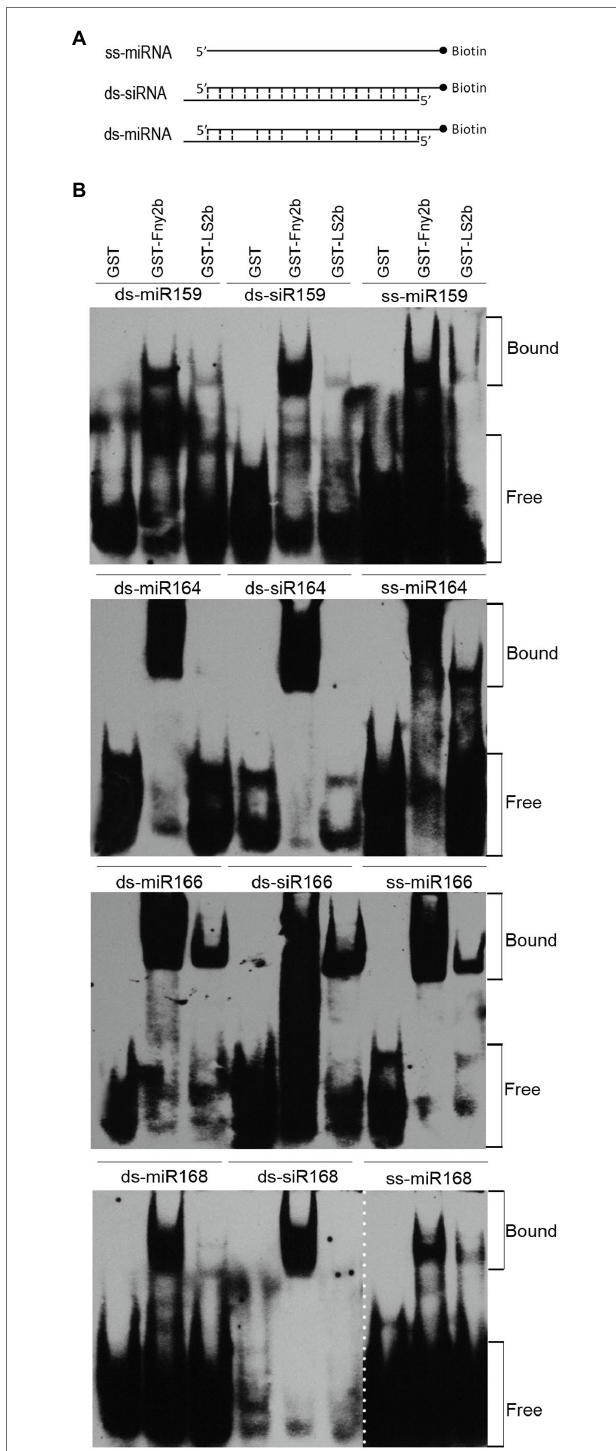
FIGURE 4 | LS2b was substantially weaker than Fny2b in binding small RNAs (sRNAs) in vitro . (A) Schematic diagram of three different forms of sRNAs. Single stranded miRNA (ss-miRNA), miRNA duplex (ds-miRNA) and siRNA duplex (ds-siRNA) of four Arabidopsis microRNAs (miR159, miR164, miR166, miR168) commercially synthesized were used in the assay